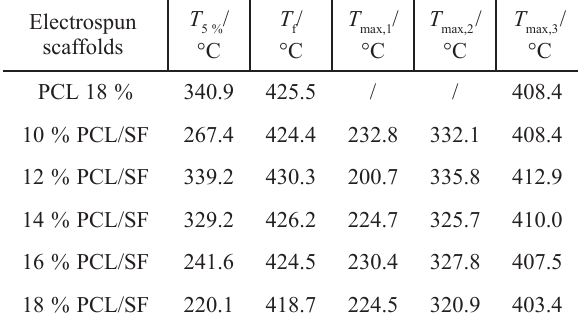
Table 3 – Results of TG analysis for the pure electrospun PCL and electrospun PCL/SF scaffolds